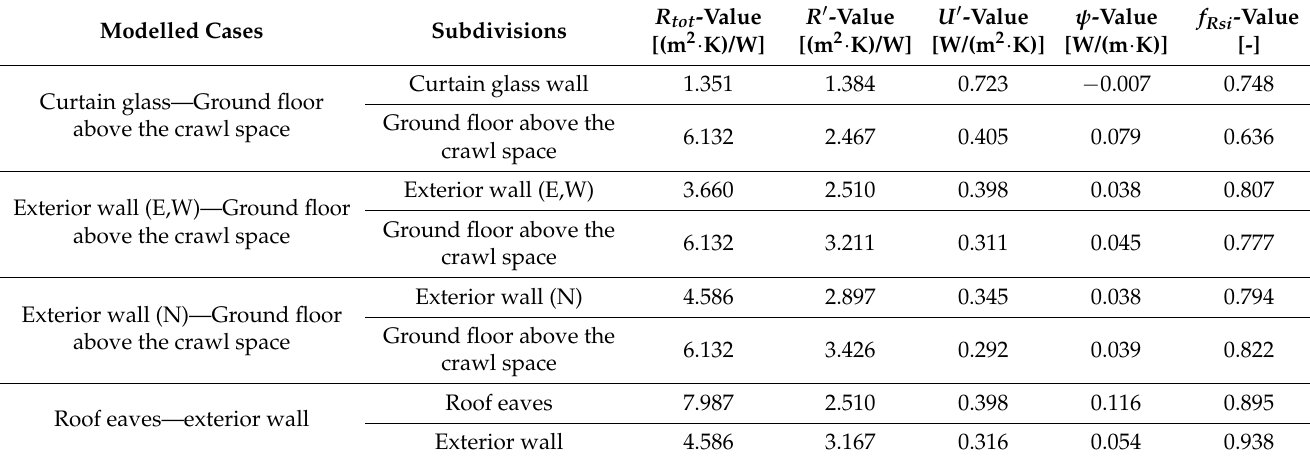
Table 4. Modelled and simulated junctions-results obtained separately per wing of the modelled